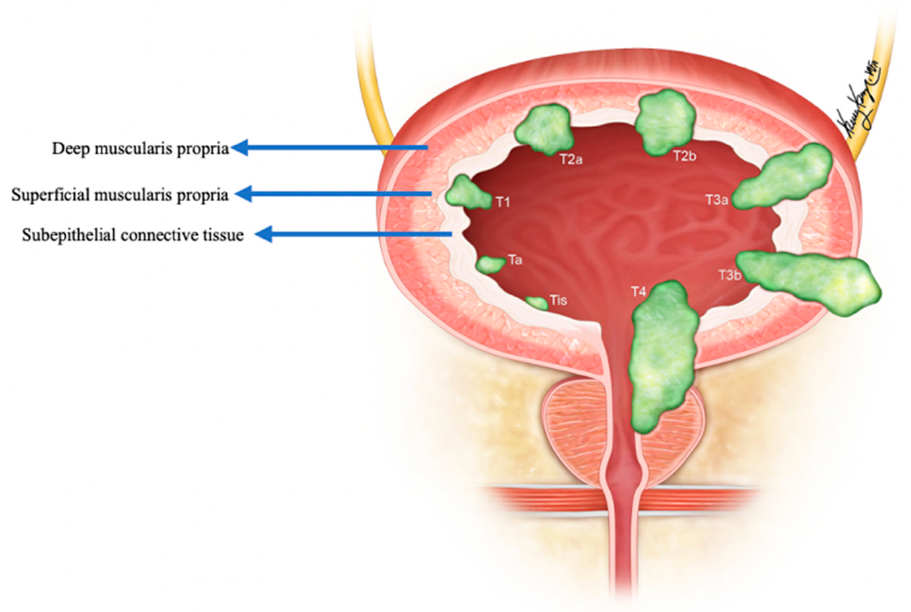
Cancers 2022 , 14 , x FOR PEER REVIEW 14 of 25 Figure 11. Staging of urinary bladder neuroendocrine carcinoma. Ta: non-invasive carcinoma; Tis: carcinoma in situ (Flat-tumor); T1: tumor invasion into subepithelial connective tissue; T2a: tumor invasion into superficial muscularis propria; T2b: umor invasion into deep muscularis propria; T3a: microscopic invasion of peri-vesical tissue; T3b: macroscopic invasion of peri-vesical tissue (extravesical mass); T4: tumor invasion of adjacent structures, pelvic or abdominal wall.